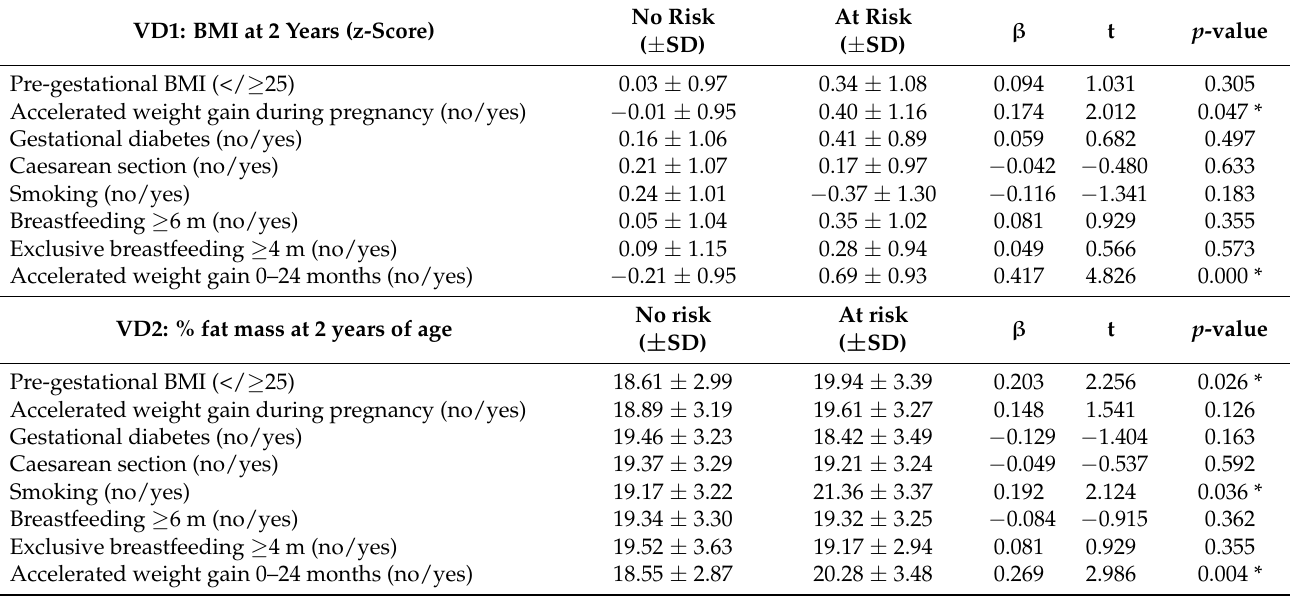
Table 3. Early risk factors predicting BMI z-score at 2 years and percentage fat mass according to multiple linear regression